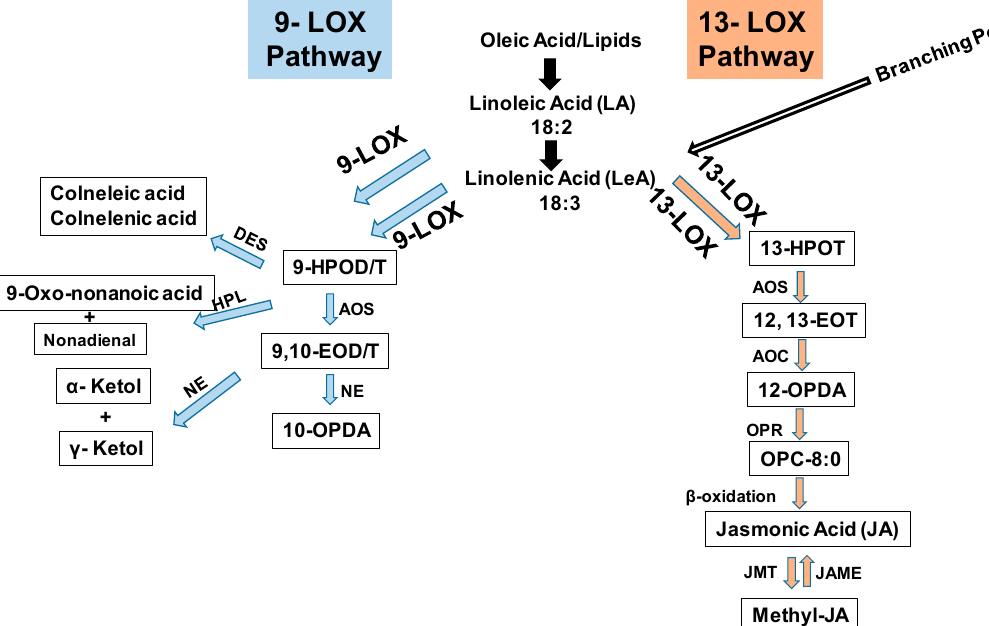
Figure 1. A schematic representation of 9-LOX and 13-LOX pathways in plants [47,48]. Abbreviations: HPOD: 9 or 13-hydroperoxide linolenic acid; 13(S) or 9(S)-hydroperoxylinolenic acid; OPDA: 12-oxo-phytodienoic acid; LOX: Lipoxygenase; AOS: Allene oxide synthase; AOC: Allene oxide cyclase; OPR: Oxo-phytodienoic acid reductase; JMT: Jasmonic acid carboxyl methyltransferase; JAME: Methyl jasmonate esterase; HPL: Hydroperoxide lyase; DES: Divinyl ether synthase. NE: Non-enzymatic.